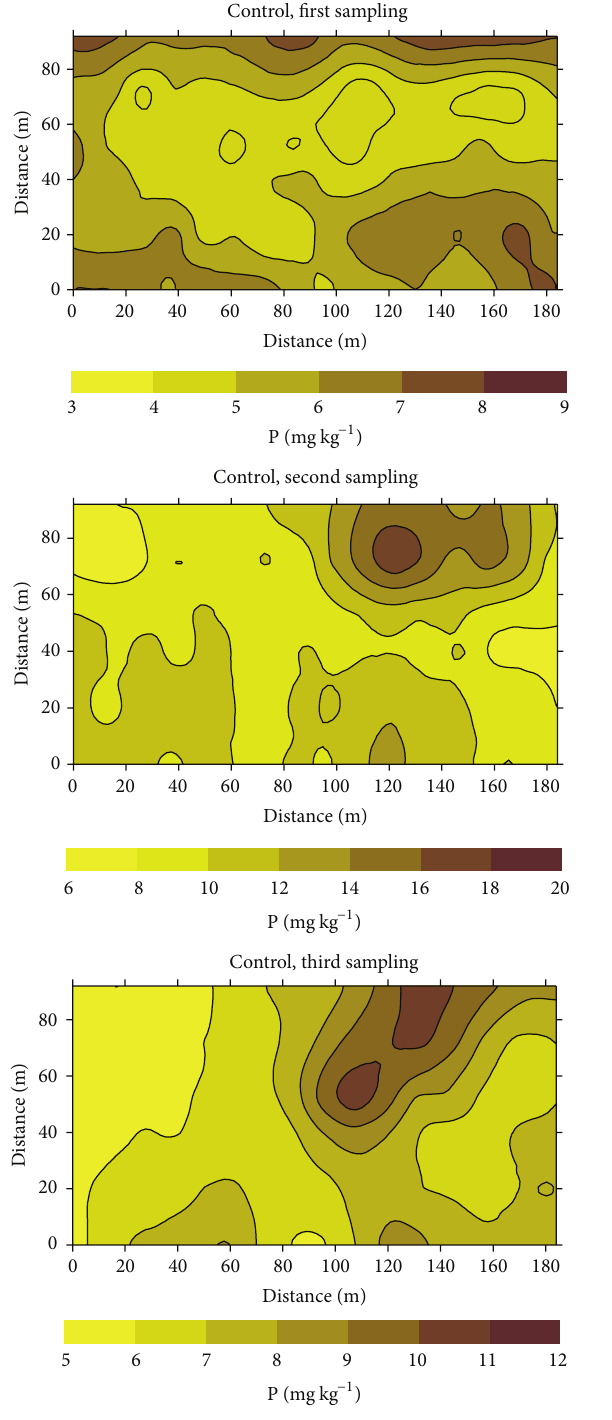
Figure 5: Kriging maps for Olsen extractable phosphorus (P) at the control treatment, for successive sampling dates.